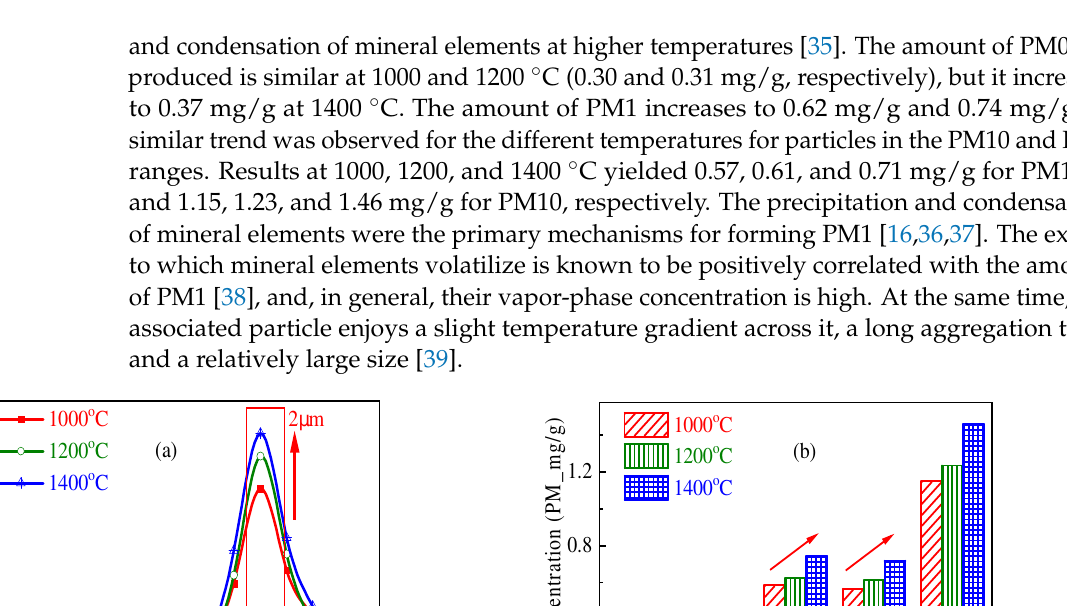
is very similar (6.2 and 6.9%, respectively), significantly greater than that observed at 1000 ◦ C (1.7%). The most volatile elements reached the maximum value at 1400 ◦ C, slightly increasing at 1200 ◦